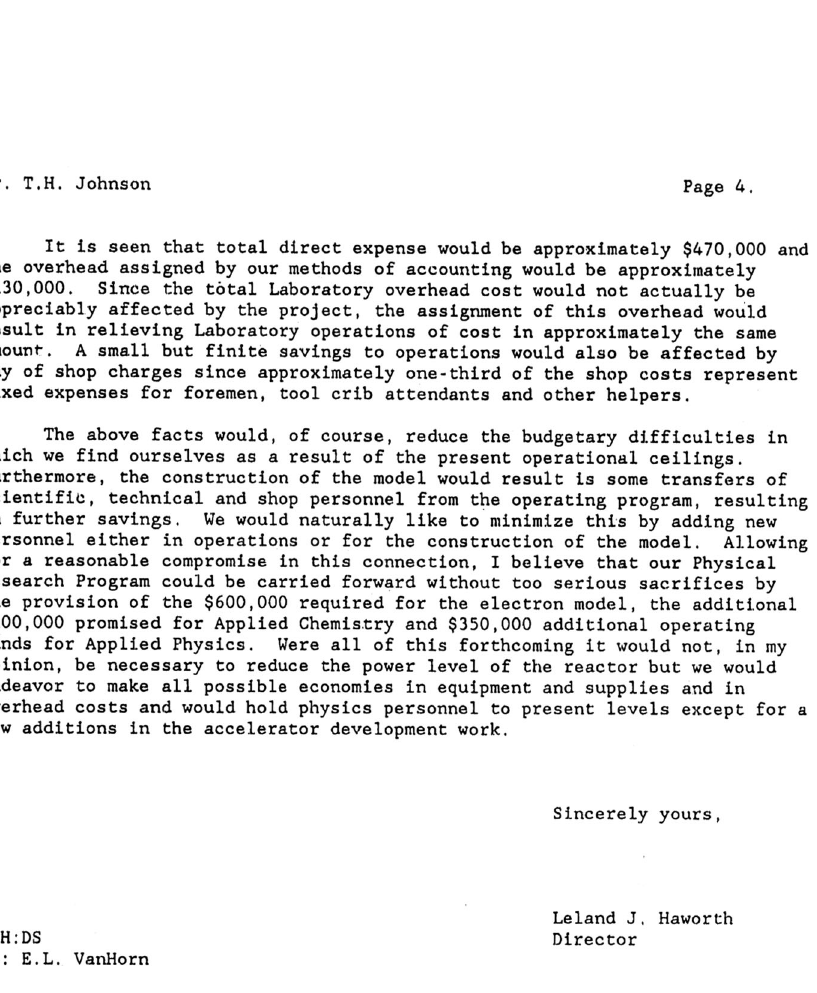
FIG. 11. Haworth letter, page